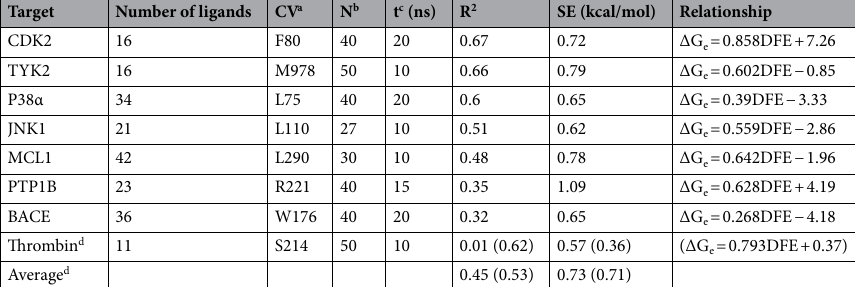
Table 3. R 2 , standard errors (SE) and relationships between DFE and experimental binding free energies ∆G e for 8 protein targets with different sets of ligands, as well as the simulation conditions. a A CV was defined by the distance between the centroid of the backbone heavy atoms of a residue of the corresponding protein and the centroid of the heavy atoms of the corresponding whole ligand, except that, for TYK2 and Thrombin, the C β was also included in the definition of the corresponding centroid; and for CDK2, P38α and BACE, the heavy atoms of a whole residue were used. b The number of runs performed for each ligand. c Chemical time of a run. d The numbers in the parentheses correspond to the results after exclusion of two outlier points in the Thrombin data